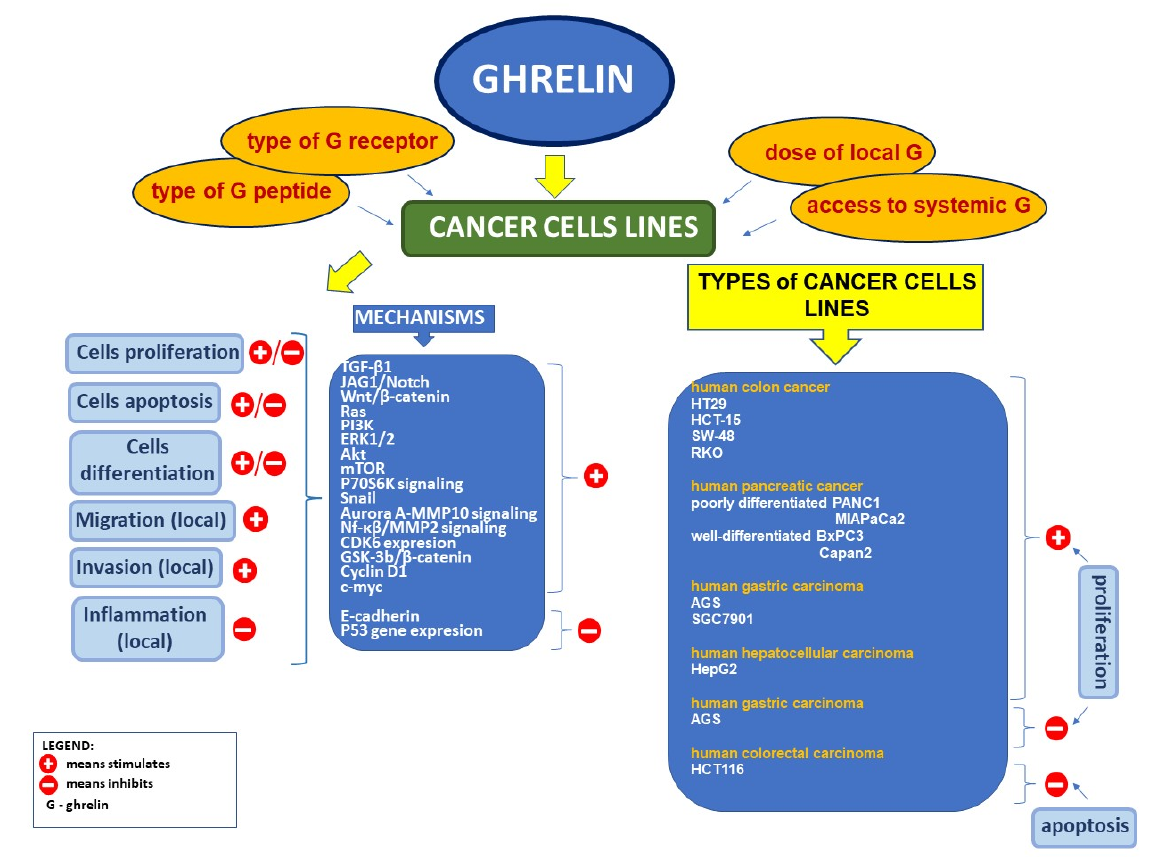
Figure 2. Effects of ghrelin on cancer cell lines.